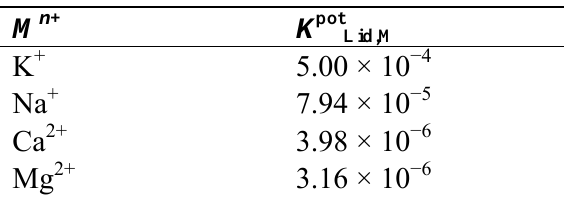
Table 1. Potentiometric selectivity coefficient of lidocaine electrodes with various interfering cations ( M n + ).